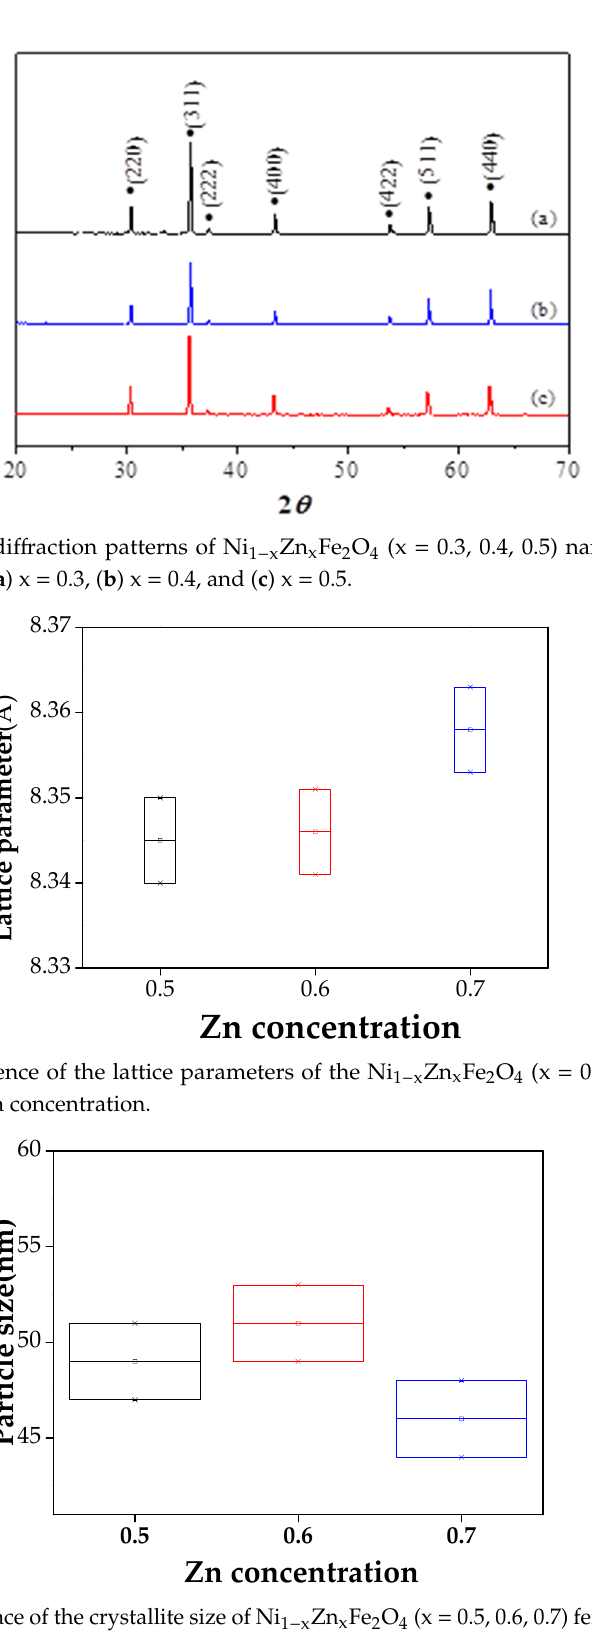
Figure 5. The dependence of the crystallite size of Ni 1 − x Zn x Fe 2 O 4 (x = 0.5, 0.6, 0.7) ferrite nanoparticles on the Zn concentration.